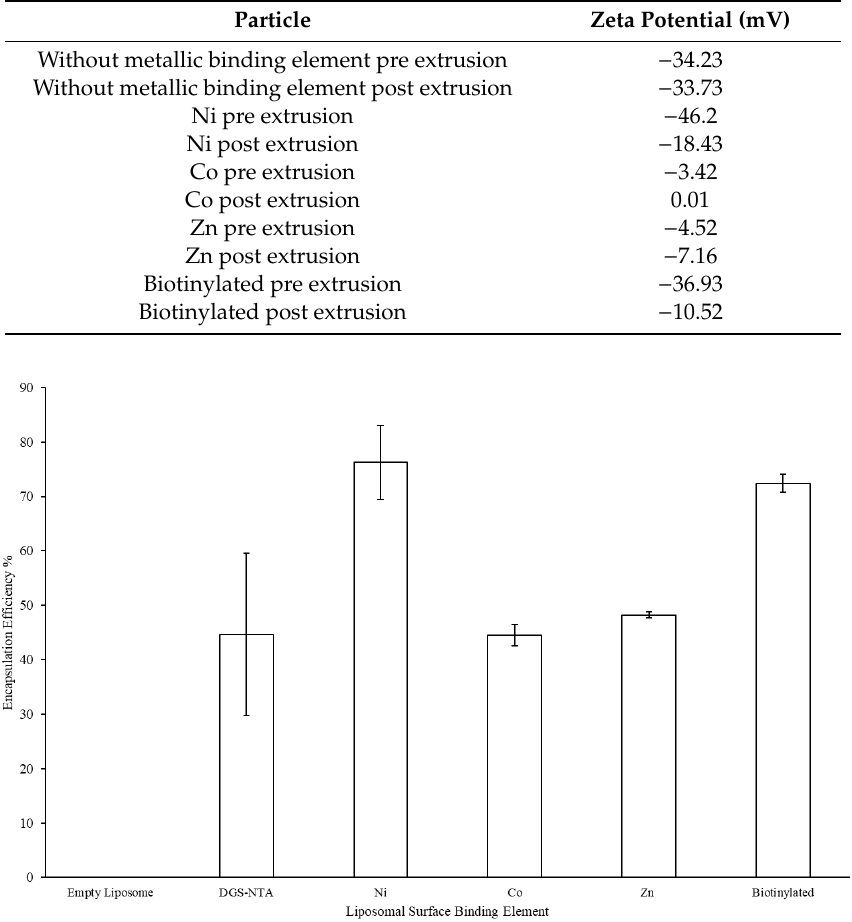
Figure 3. Liposomal encapsulation efficiency of polysaccharide 19F across variants with different protein surface binding elements.